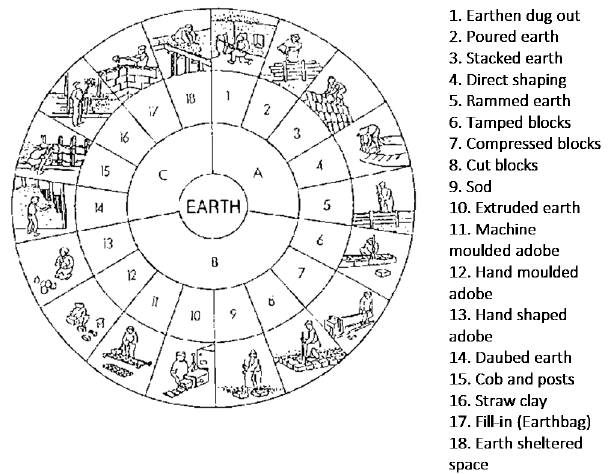
Figure 2. Main earth techniques classification, according to water content [8].